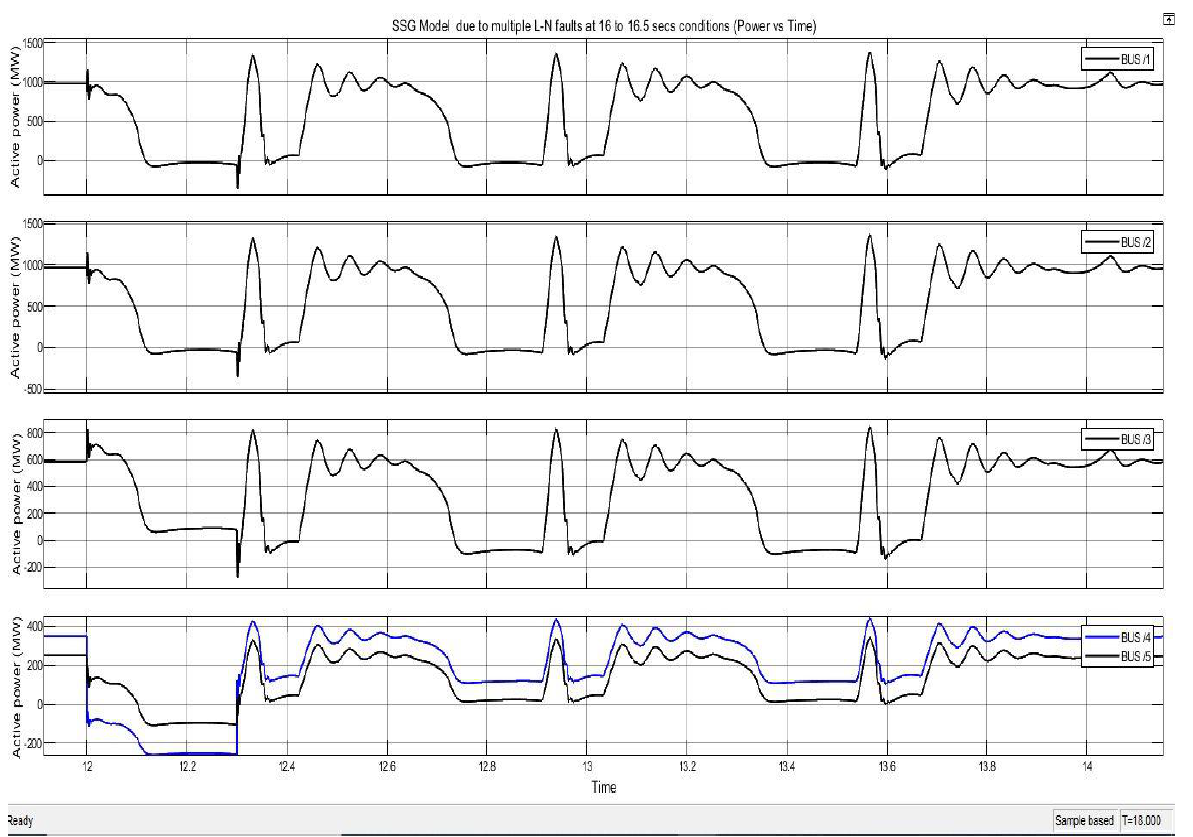
Figure 18. Multiple line-to-ground faults are inserted in the system from 12 to 12.3 s (Bus 1 to Bus 5).